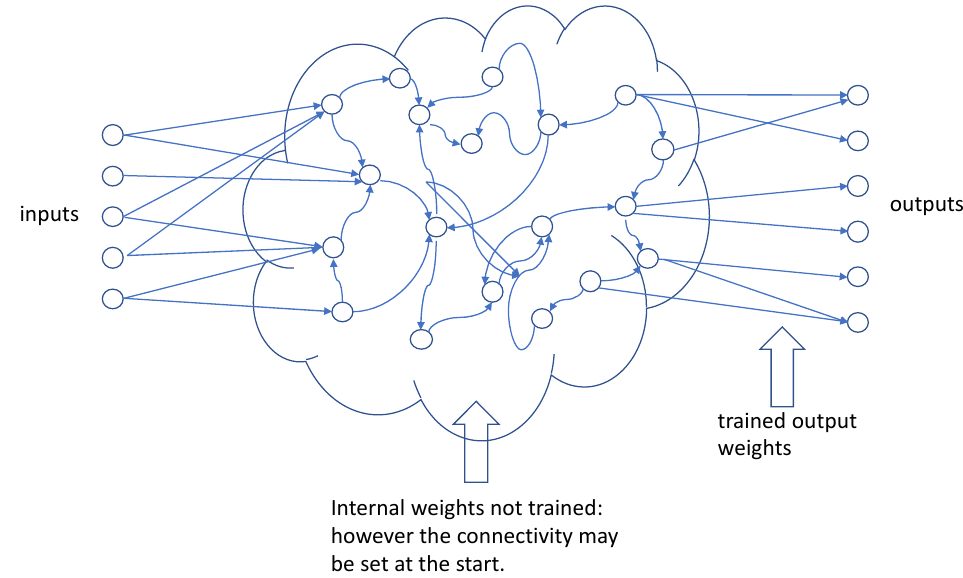
Figure 1. Schematic of a reservoir neural network. The number of nodes in the reservoir, their connectivity, and their weights are fixed and sometimes called the hyperparameters. The internal weights are not trained. Only the output weights are trained (compare with Figure 2b). Typically, the internal weights are configured at the start (Goodfellow et al. 2016) [11]; however, with a dynamic media like PZT, or other programmable matter, one effectively achieves the same result by submitting the same set of control strings with the input data stream.